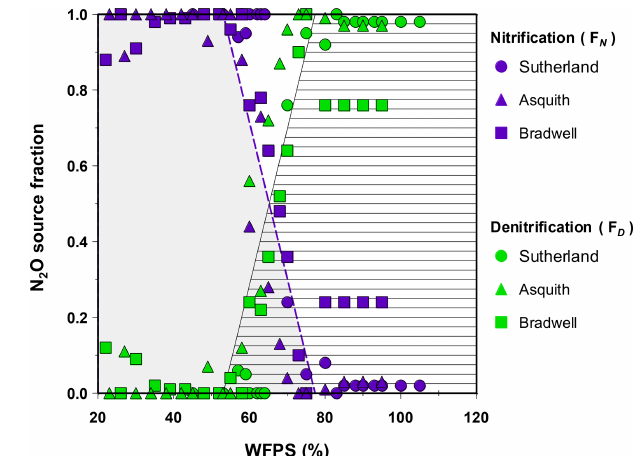
Figure 4. Fraction of emitted N 2 O that was attributed to nitrifica- tion ( F N ; shaded grey area) or denitrification ( F D ; lined area) based on the isotopomer mixing model (data points). Note: the dashed purple line denotes the predicted F N (Eq. 6); the solid black line denotes the predicted F D (Eq.